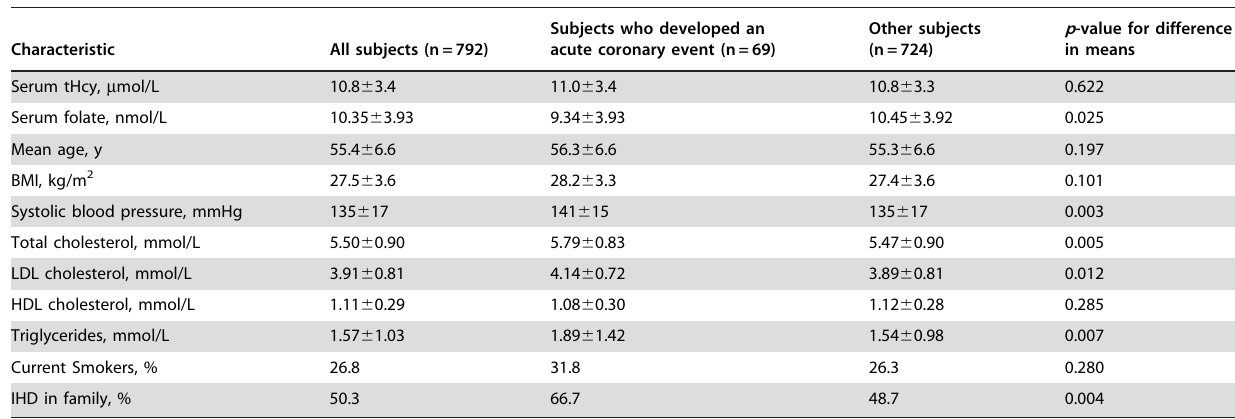
Table 1. Baseline characteristics of the study subjects * .. ... .... ... ... .... ... ... .... ... ... .... ... ... .... ... ... .... ... ... .... ... ... .... ... ... .... ... ... .... ... ... .... ... ... .... ... ... .... ... ... .... ... ... . Characteristic All subjects (n=792)